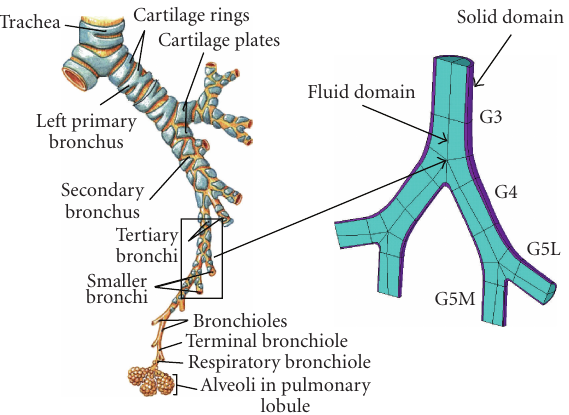
Figure 2: Geometric representations of the airway generations 3 to 5 based on ICRP [22] tracheobronchial geometry and measurements by Habib et al. [23]. These bifurcations were used as a computational domain for this study.